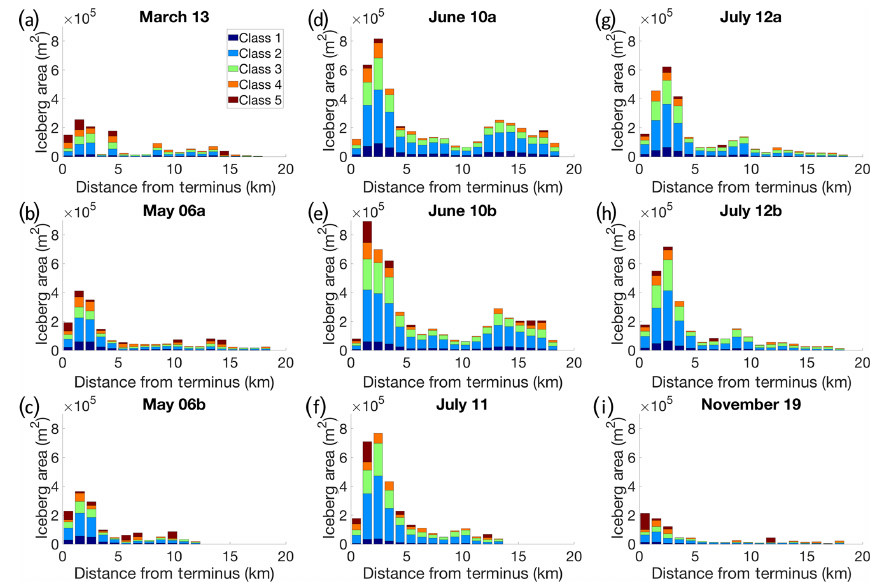
Figure 5. Total area of icebergs per 1km bin along the fjord. The dates shown here are (a) 13 March, (b) 6a May, (c) 6b May, (d) 10a June, (e) 10b June, (f) 11 July, (g) 12a July, (h) 12b July, and (i) 19 November. The peak of ice coverage inside the fjord is found 2–3km from the terminus. The icebergs are divided into classes by waterline cross-sectional area, with the smallest icebergs residing in Class 1 and the largest in Class 5. The divisions for the bins were 0–10m 2 , 10–100m 2 , 100–1000m 2 , 1000–10000m 2 , and 10000–100000m 2